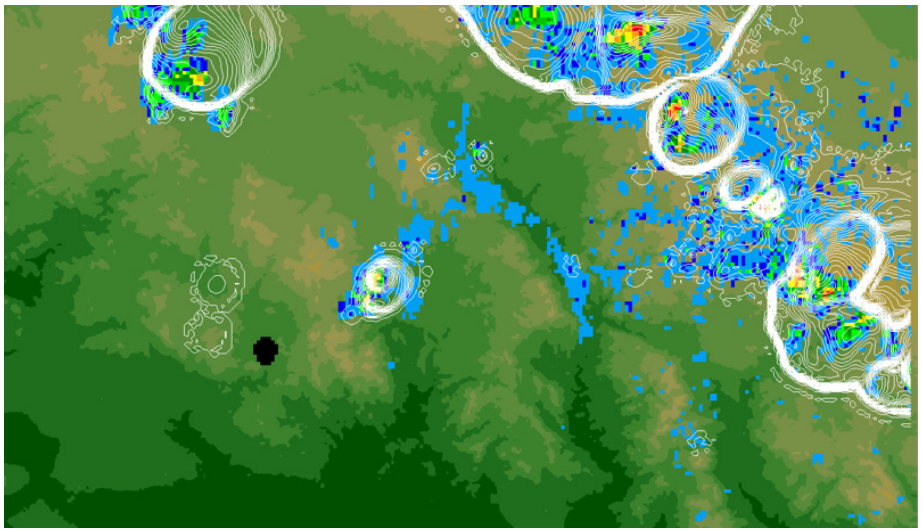
Figure 5. Valid at 1231 LST. Gust front model elevation map overlain by radar echoes (multi-colored pixels) and temperature contours (white lines) identifying locations of gust fronts. The location of the smoke plume from the Yarnell Hill fire as observed by radar is given by the blackened circle.